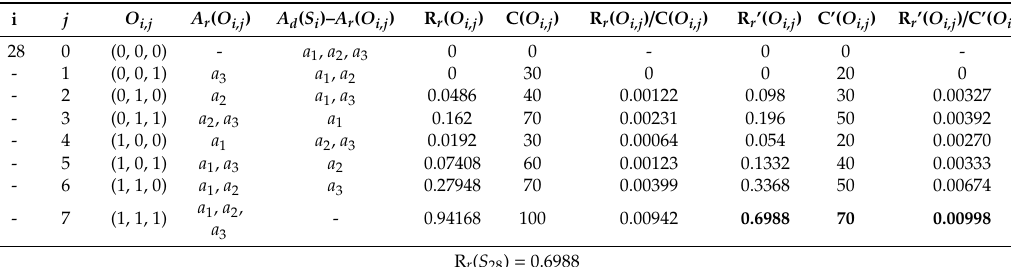
Table 3. All the O i,j for i = 28 from Figure